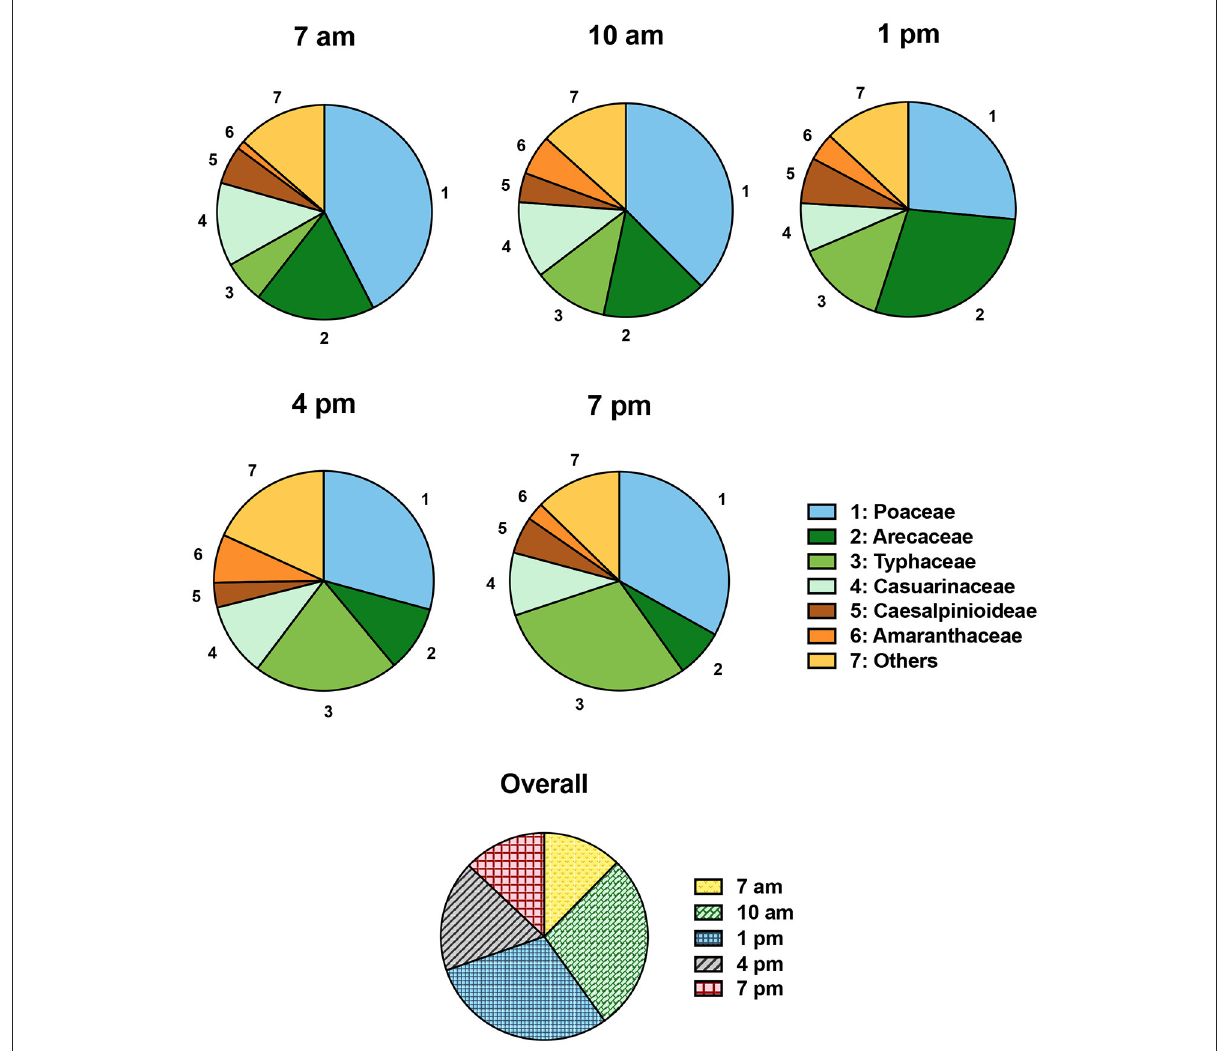
FIGURE3 Compositions of individual pollen type during each diurnal